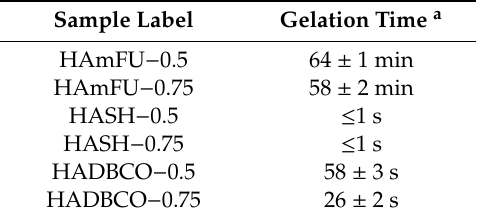
Table 3. Summary of pipettability-based gelation